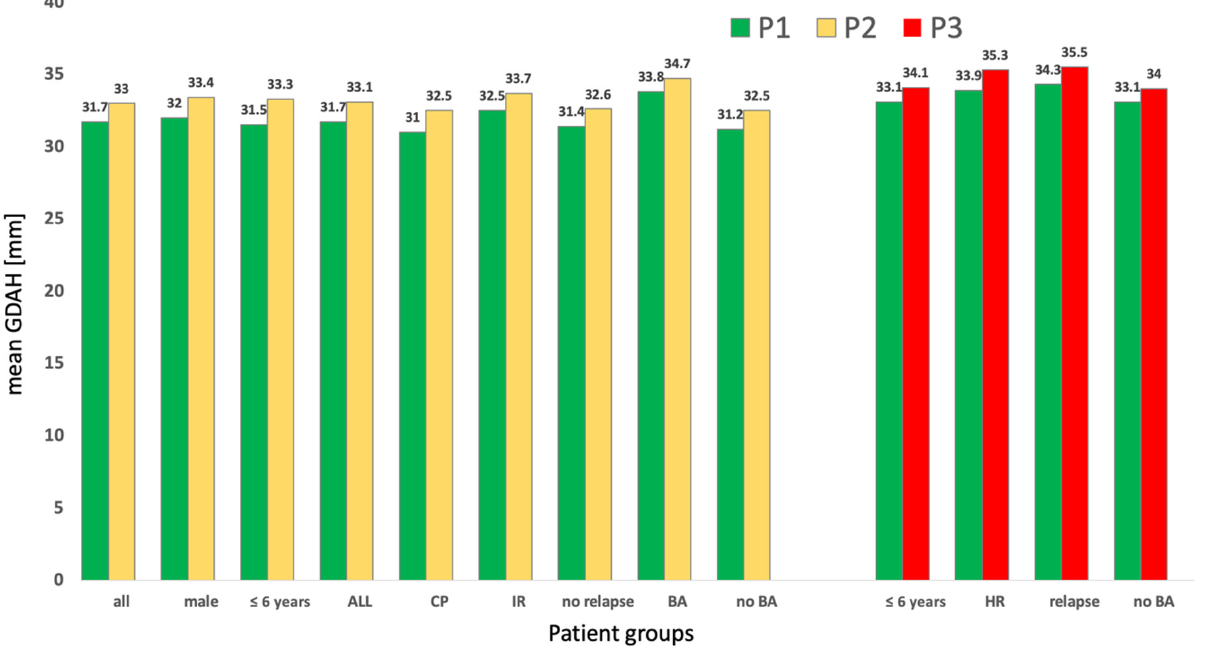
Figure 3. The change in mean ventricular width (GDAH) in individual patients between different time periods (P1, P2 and P3) is displayed. Only significant changes ( p < 0.05) are shown (CP: cerebral pathomorphologies; IR: intermediate risk; HR: high risk; BA: brain atrophy). 3.2. Intrathecal Methotrexate (ith. MTX) in Patients with Acute Leukemia Altogether, 1393 ith. MTXs applications were given to 94 patients (Table 1). Table 1 . Number of intrathecal (ith.) MTX applications in ALL and AML.